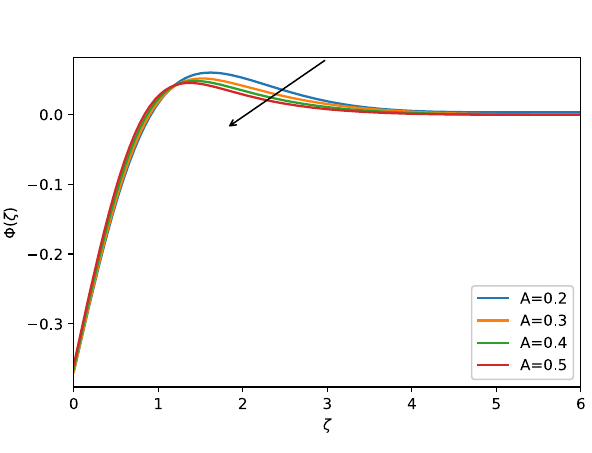
Fig. 13 Θ( 𝜁 ) against Rd